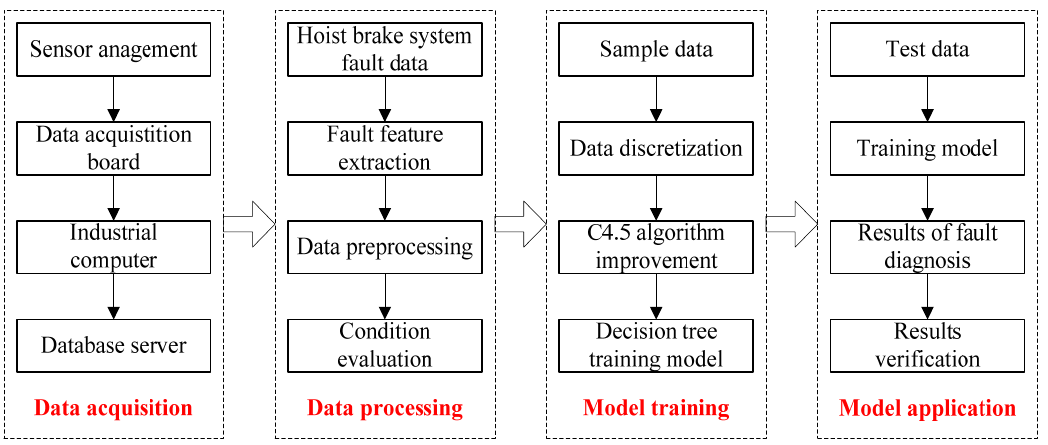
Figure 2. Fault diagnosis frame of mine hoist brake system based on machine